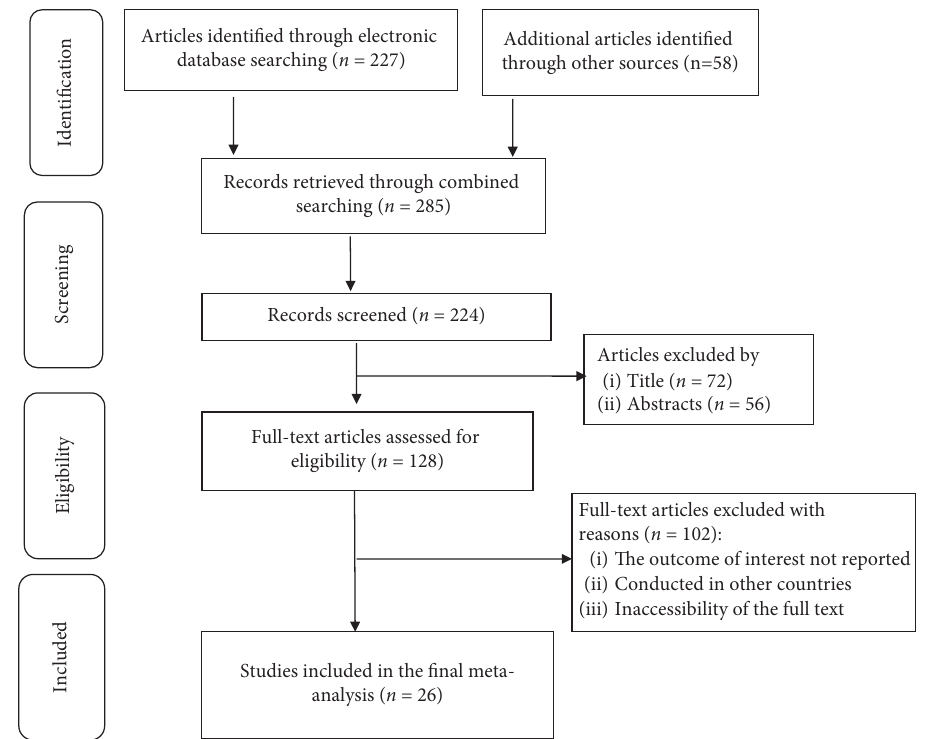
Figure 1: PRISMA-adapted flow diagram showing the results of the search and reasons for the exclusion of articles